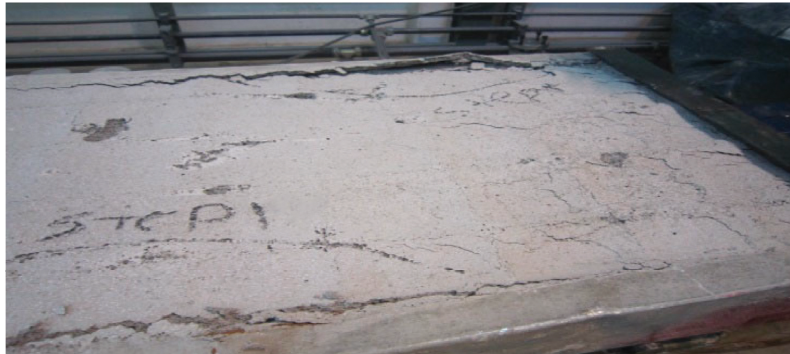
Figure 18: Deep longitudinal cracks between the cold-rolled galvanized sheets and the foamed